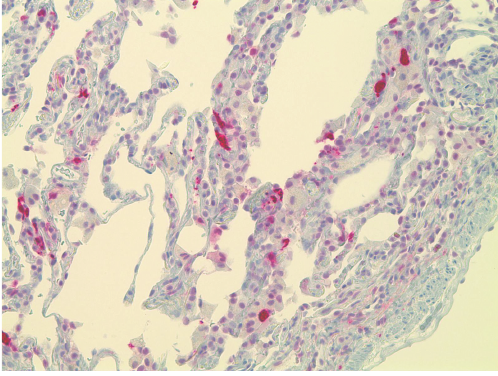
Figure 4: S100 protein